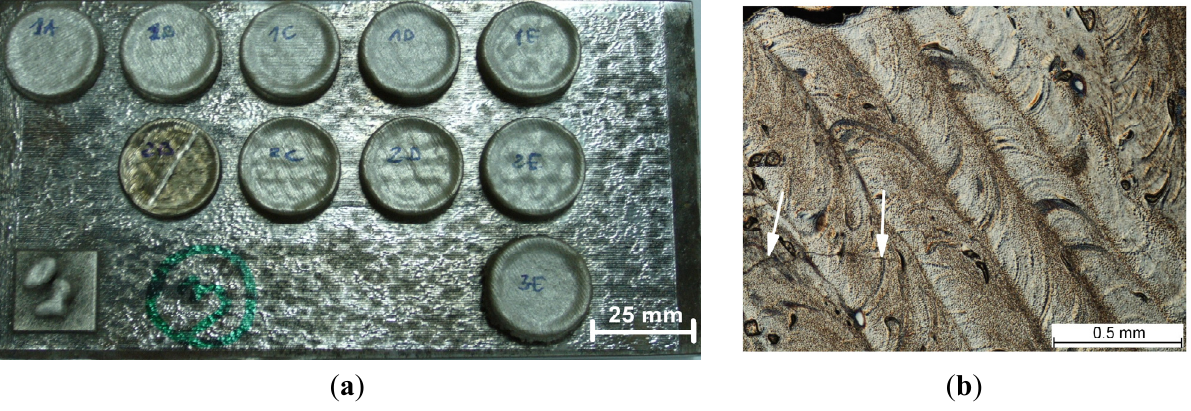
Figure 1. ( a ) Fe-Al-Ti samples deposited by the LENS method; and ( b ) layered structure of the deposited sample no. 1 (view from the top of the sample). Arrows indicate